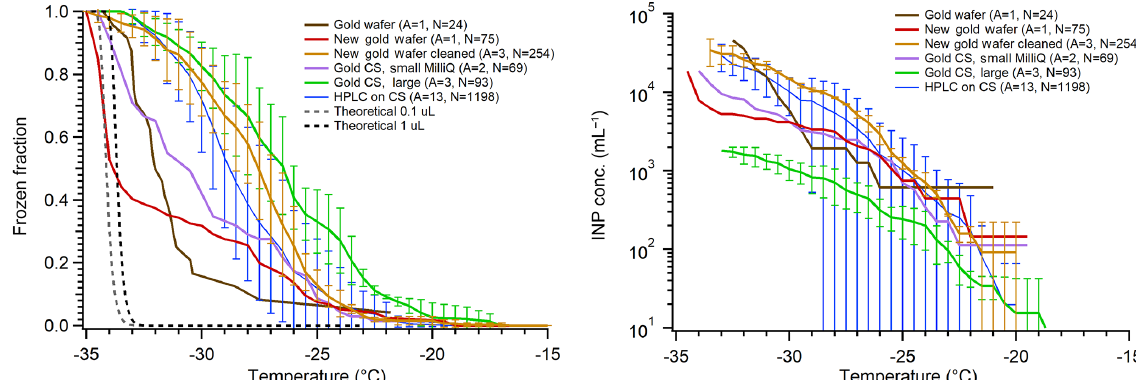
Figure 8. Measurements of pure water droplet freezing on gold substrates are shown following Fig. 5. The data from small HPLC water droplets on a silanized cover slip are displayed in blue for comparison (Fig. 5, blue). The gold data displayed are using HPLC water droplets on a gold wafer substrate (brown), small MilliQ droplets on a gold-coated glass cover slip (gold CS) (lilac), and large HPLC water droplets on a gold CS (green). Also displayed are data from small droplets on another gold wafer upon first use (red), and subsequent small droplet arrays on the same wafer following cleaning and drying, with associated error bars (orange). The parentheses next to each legend entry contains the number of arrays of droplets ( A ) and the total number of droplets across all arrays ( N ). Error bars show standard deviation from replicate droplets arrays. The data from the gold wafer (brown and red) and small droplets on a gold CS (lilac) were combined into one series and so no error bars are derived. The gray and black dashed lines indicate the theoretical homogeneous freezing curve of 0.1 and 1µL droplets, respectively, using the parameterization of Koop and Murray